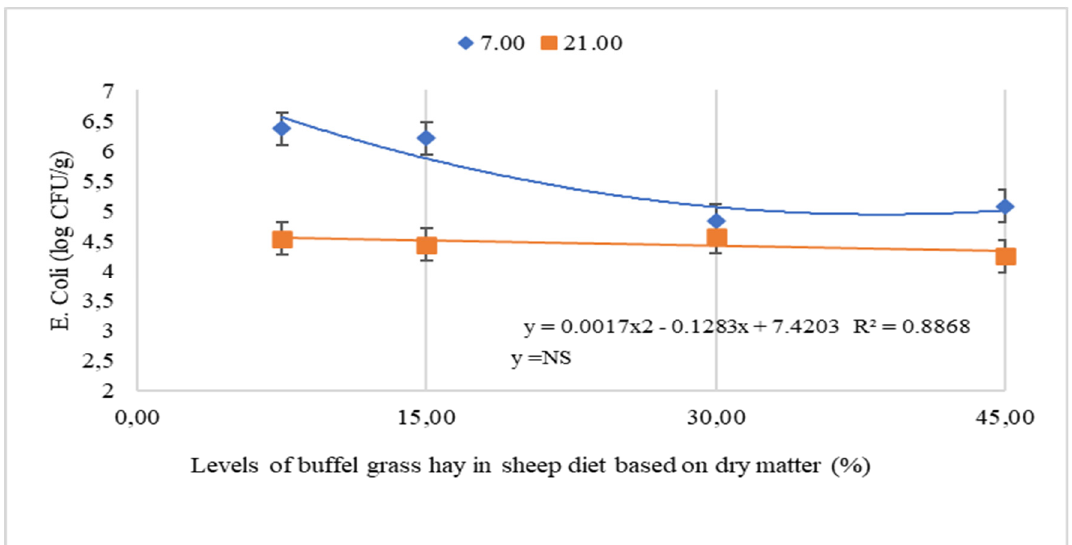
Figure 2. Growth of Escherichia coli in the leftovers of sheep fed levels of buffel grass hay and cactus pear. CFU = colony forming unit. 7.00 = 7th day and 21.00 = 21st day. On the first day of collection, leftovers of animals consuming the lowest levels of buffel grass hay (7.5% and 15%) had the highest count values for both Enterobacteriaceae (7.97 log CFU/g and 6.37 log CFU/g) and E. coli (6.64 log CFU/g and 6.21 log CFU/g) compared to the 21st day, with values of 5.46 log CFU/g for Enterobacteriaceae and 4.54 log CFU/g for E. coli (7.5% buffel hay) and 4.41 log CFU/g for Enterobacteriaceae and 4.44 log CFU/g for E. coli (15% buffel hay). The counts in the leftovers of animals consuming 30% and 45% buffel grass hay did not differ between collection periods, with mean values